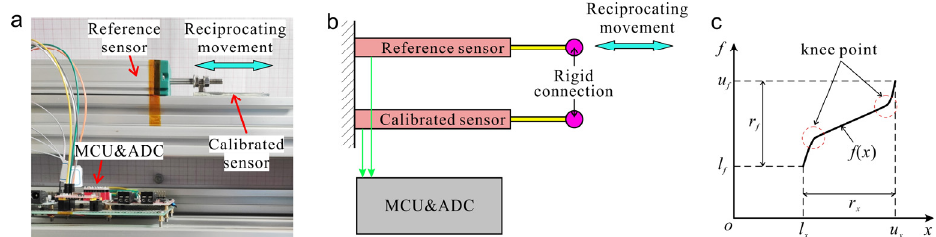
Figure 2. Calibration experiment of the linear potentiometer. ( a ) Experimental setup; ( b ) schematic diagram of the calibration experiment; ( c ) illustration of the rational Bezier calibrating